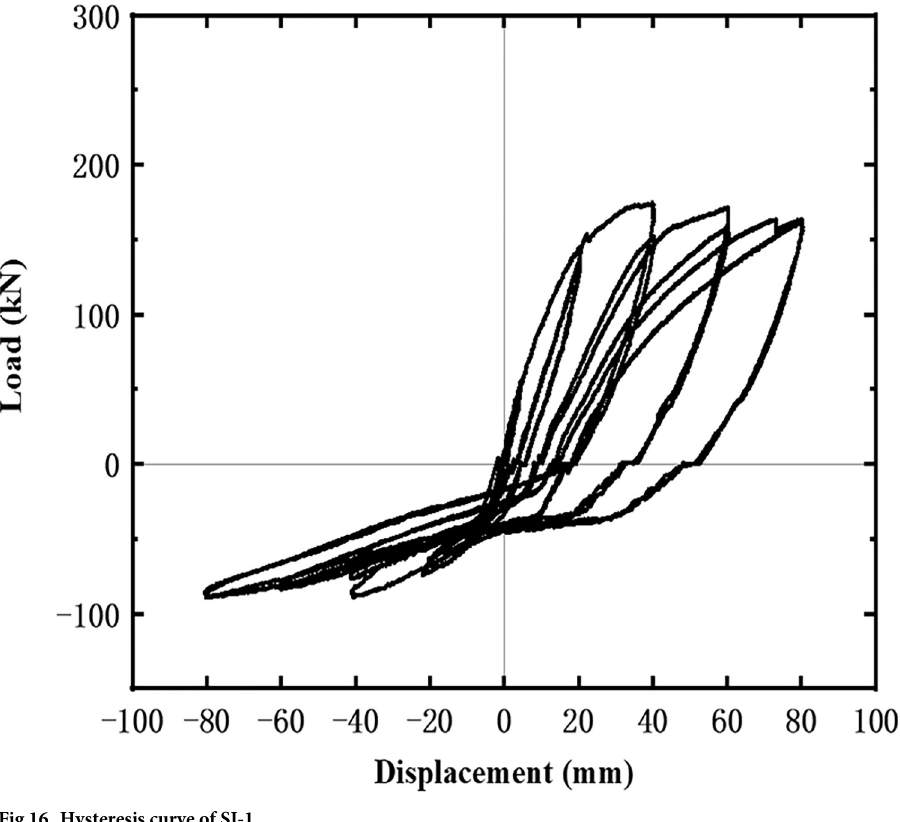
Fig 16. Hysteresis curve of